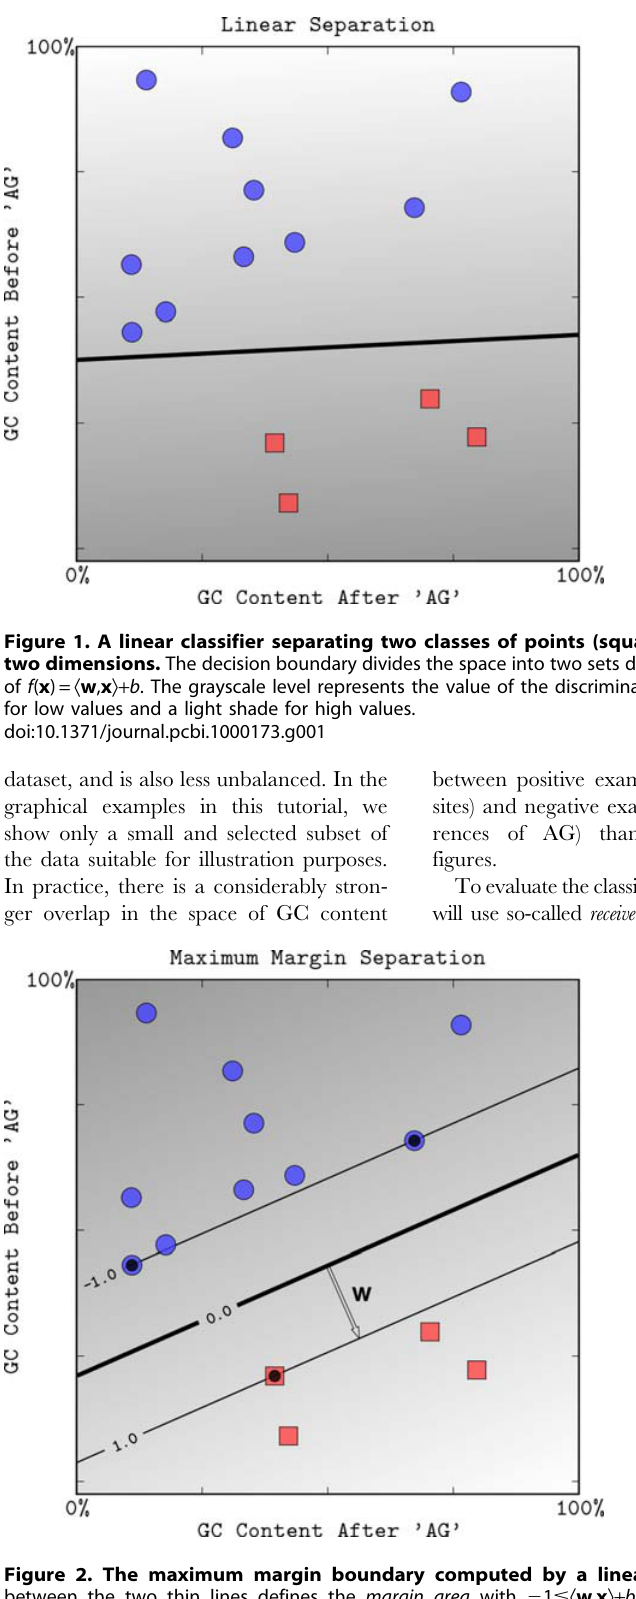
PLoS Computational Biology |